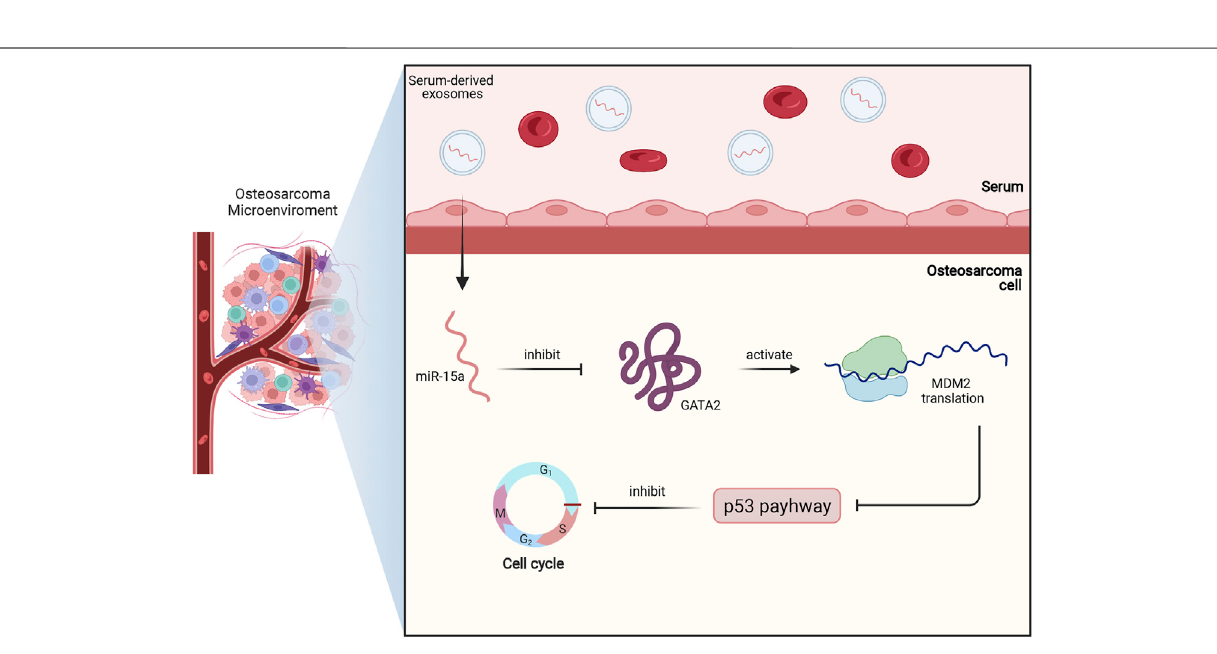
Frontiers in Pharmacology |